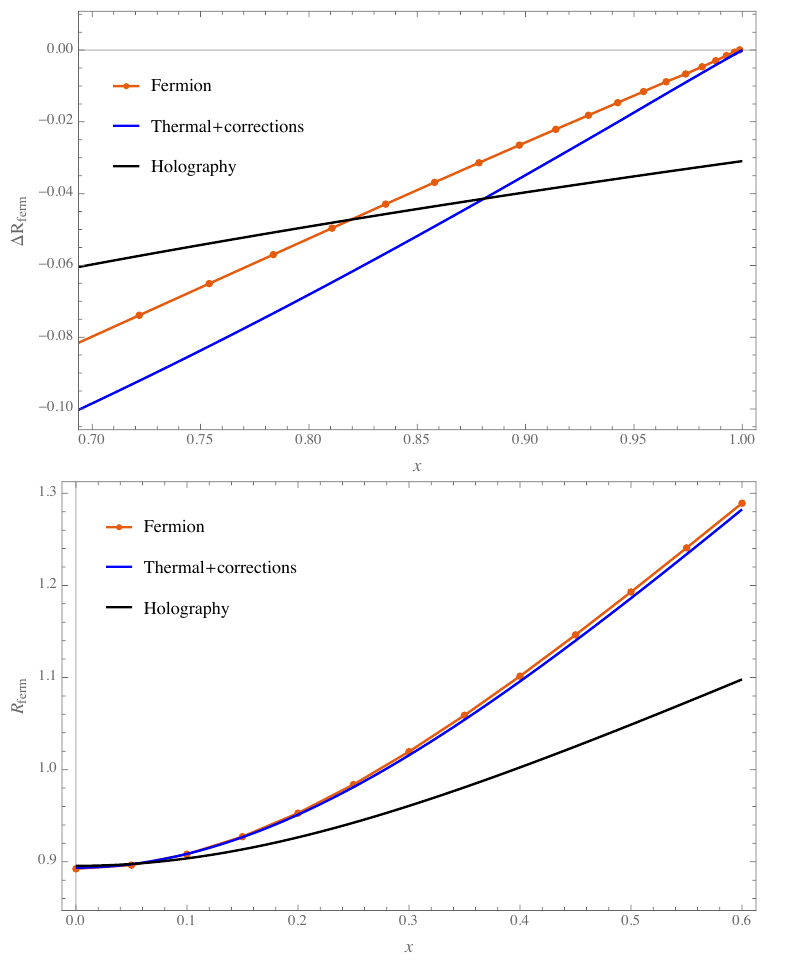
Figure 7 . (Top) The free fermion deflected entropy ∆ R ferm for fixed s = 0 . 2 with the asymptotic term 1 / 6( − ln(1 − x )+2 ln(cosh πs )) subtracted, plotted against the thermal prediction with correc- tions (4.60) and holographic CFTs. (Bottom) The deflected entropy for fixed cross-ratio x = 0 . 981 and variable s , plotted against the same analytical prediction and holographic